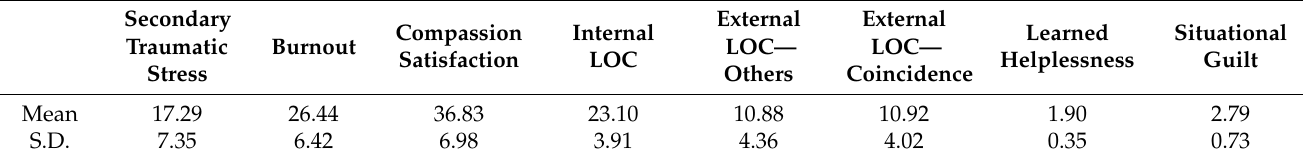
Table 2. The average scores and SDs of the study’s